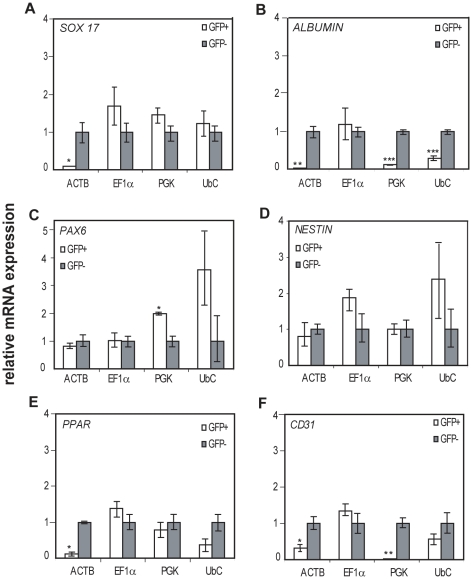
Activity of promoters in cell types representing all three embryonic germ layers.hESCs were spontaneously differentiated for 22 days and thereafter separated by FACS sorting into the eGFP+ and eGFP− cell populations. Relative gene expression was performed by qPCR on the eGFP+ and eGFP− populations. A–F. Expression analysis of genes representative for differentiation to the three embryonic germ layers; endoderm, mesoderm and ectoderm. SOX17(A) and ALBUMIN(B) originates from endoderm. Neural progenitors PAX6 (C) and NESTIN (D) originates from ectoderm. E–F. Mesodermal cells; PPARγ (E) and CD31 (F). Expression levels for each gene in eGFP+ and eGFP− populations are plotted as relative to expression levels in undifferentiated hESCs. Results are plotted as mean of three independent experiments and error bars indicate ± s.d. Statistical analysis of GFP+cells compared to GFP− cells determined by students t'test (p*≤0,0392).